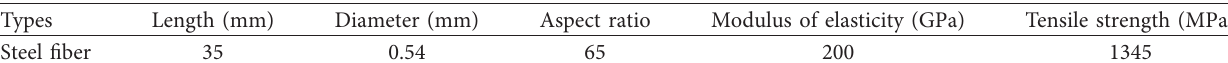
Table 2: Physical properties of steel fiber.